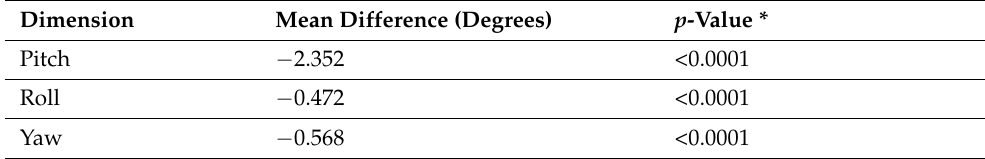
Table 8. Rotational differences and significance between PSI and conventional osteosynthesis. Dimension p -Value *